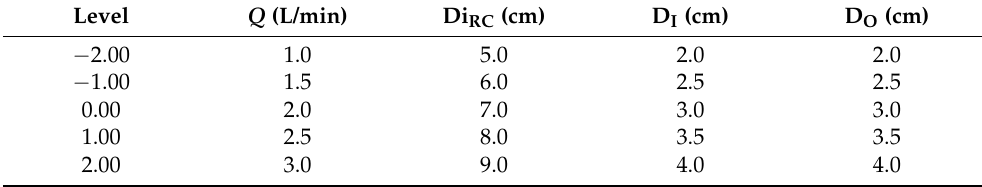
Table 2. Matrix of levels used in the factorial design for the lateral inlet and outlet configuration.